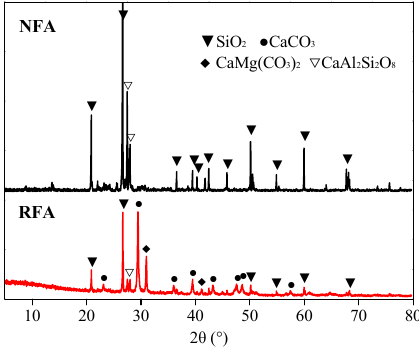
ff raction (XRD) patterns of NFA and Figure 8. X-ray diffraction (XRD) patterns of NFA and RFA. Figure 8. X-ray di